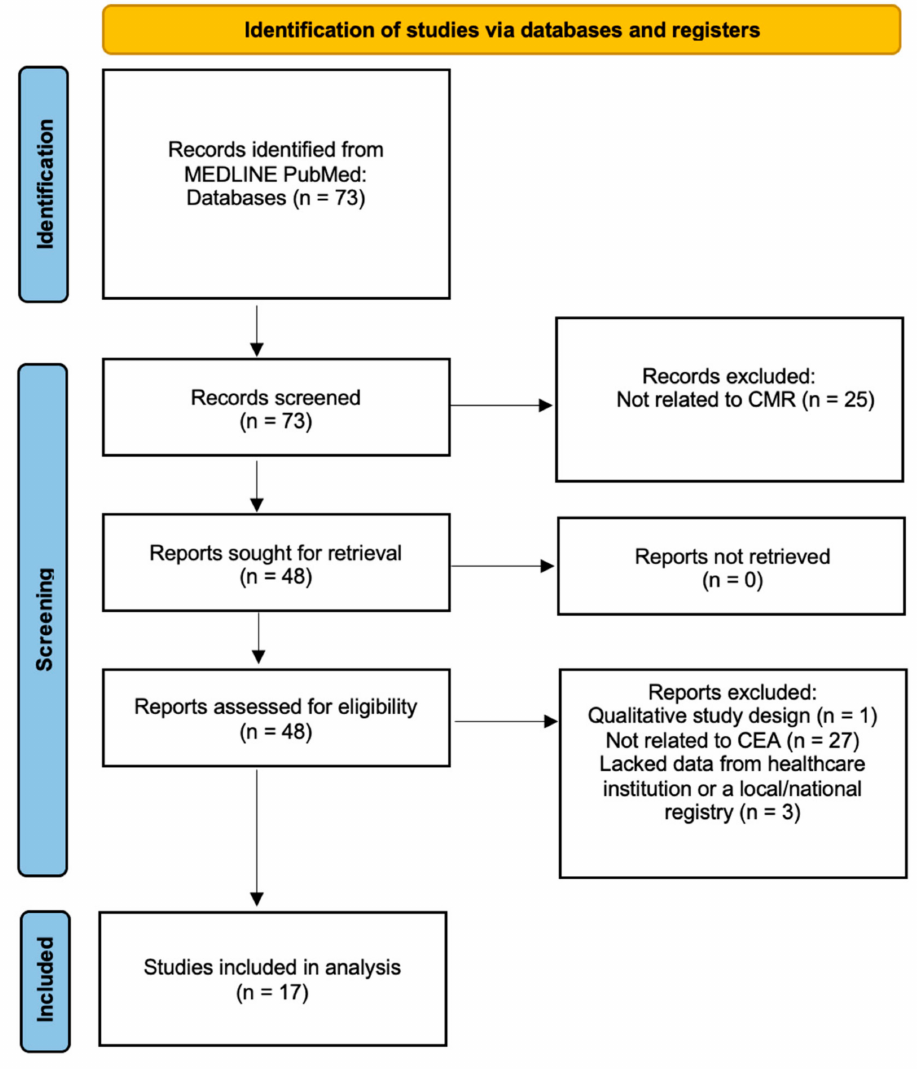
Figure 1. Flow diagram summarizing the identification of included studies (Abbreviations: CEA— Cost-Effectiveness Analysis. CMR—Cardiac Magnetic